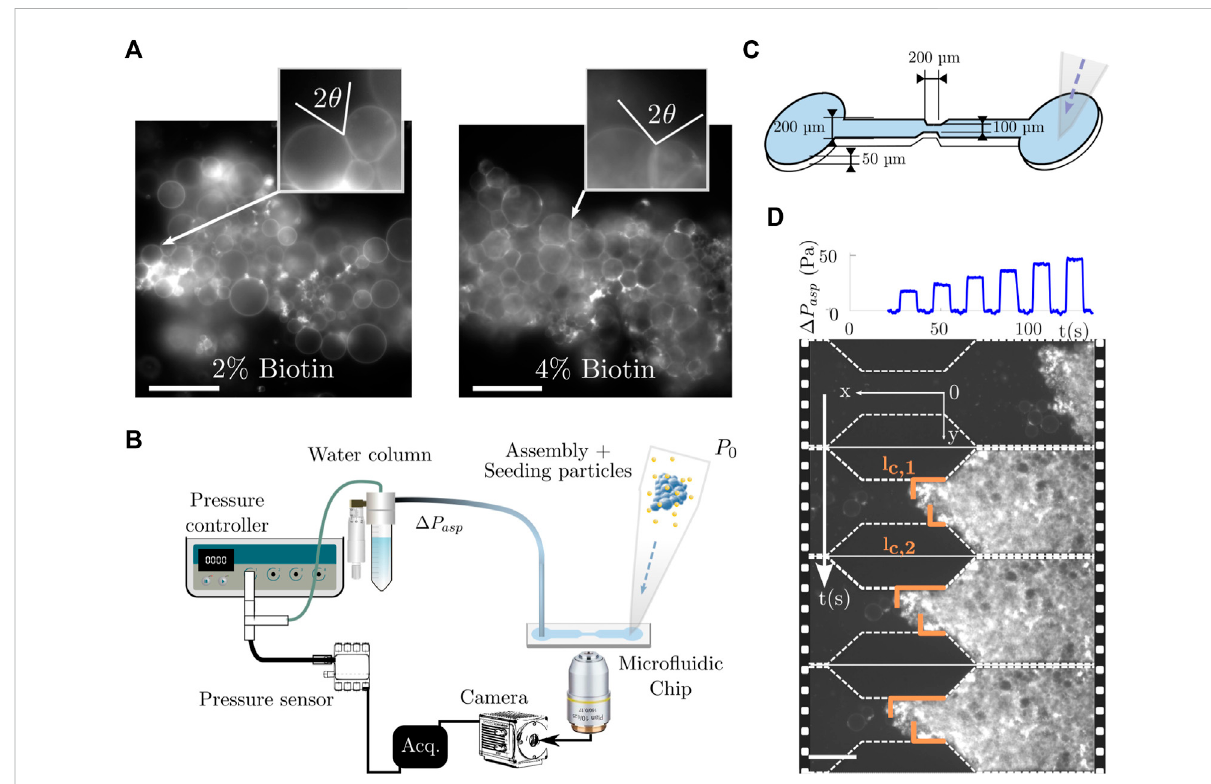
FIGURE 1 Micro fl uidic aspiration setup for prototissue rheology experiments. (A) Example of obtained prototissues after GUV assembly. Two different compositions were used: 2% and 4%- biotin vesicles with a SA-to-biotin ratio of X = 3. They led to two different adhesion degrees, quanti fi ed by the contact angle θ between outer neighbouring GUVs as shown in the inset. Scale bar is 50 µm. (B) Micro fl uidic apparatus comprising an aspiration system, the micro fl uidic chip and the microscopy acquisition device. The prototissues were injected through the pipette cone (reservoir) in the right inlet of the microchannel and aspirated to the constriction where a 20x objective was used for fl uorescence acquisition. (C) Sketch of the micro fl uidic chip used in the experiment (not to scale). The fl ow was created from right to left. (D) Example of image monitoring of the aspiration of prototissueinthemicro fl uidic constrictionwithaseriesofpressureincreasingsteps. l c ,1 and l c ,2 arethecontactlengthsbetweentheprototissue and the lateral constriction walls measured for each frame. The acquisition rate was 30fps and simultaneous pressure measurements were performed. Scale bar 100